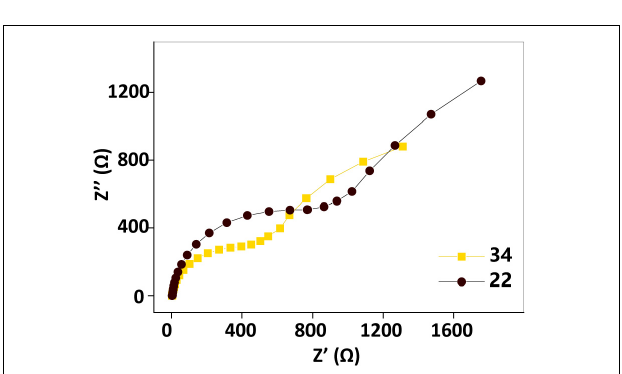
FIGURE 5 | Electrochemical impedance spectroscopy spectra before (34 ◦ C, orange squares) and after (22 ◦ C, black dots) the temperature changing operation. Test conditions: 50 µ M AQS, 50 mM lactate, 200 mM phosphate as pH buffer (pH = 7.0), OD 600 = 1.0, and external potential of 421 mV vs.